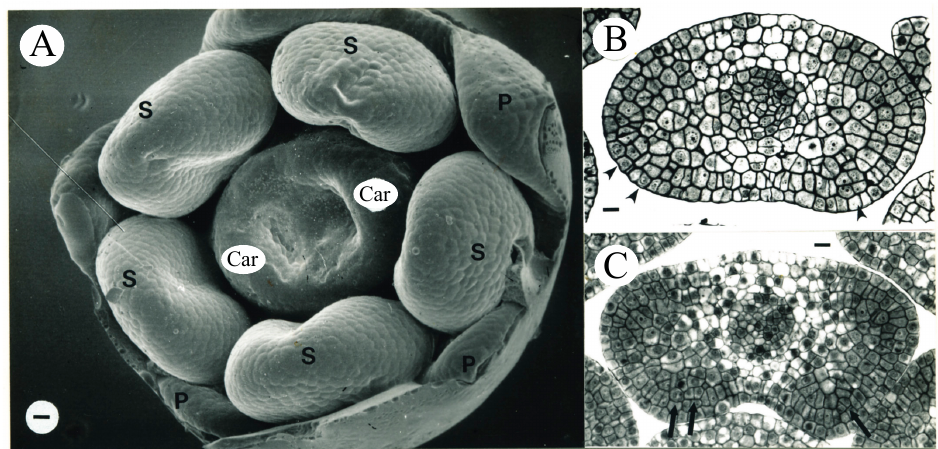
Figure 1. Scanning electron microscope (SEM) micrograph of a tobacco flower ( A ) and the transverse sections of anthers ( B ) and ( C ) following carpel initiation. This and subsequent SEM micrographs are made of epoxy casts. ( A ) Two carpel primordia (Car) initiated. This flower is corresponding to Stage –7, as described in [30]. This stage is here defined as the early carpel primordial (ECP) and is set at zero on the time scale for all of the other flower ages reported in the present study. S, stamen; P, petal primordium. Bar = 18 µm. ( B ) An anther from the flower shown in (A). Three recent periclinal divisions of L2 cells are evident (arrowheads). Bar = 14 µm. ( C ) Transverse section of a representative anther from the age interval 1.3 ± 1.2 days after ECP. Recent periclinal divisions of L2 cells are evident (arrows). Bar = 16.7 µm. Table 3. Temporal comparisons of the stamen and anther development in tobacco between the current and two previous studies [6,30].